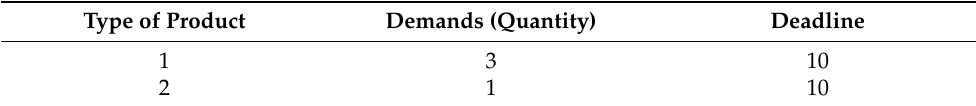
Table A1. Order Data.